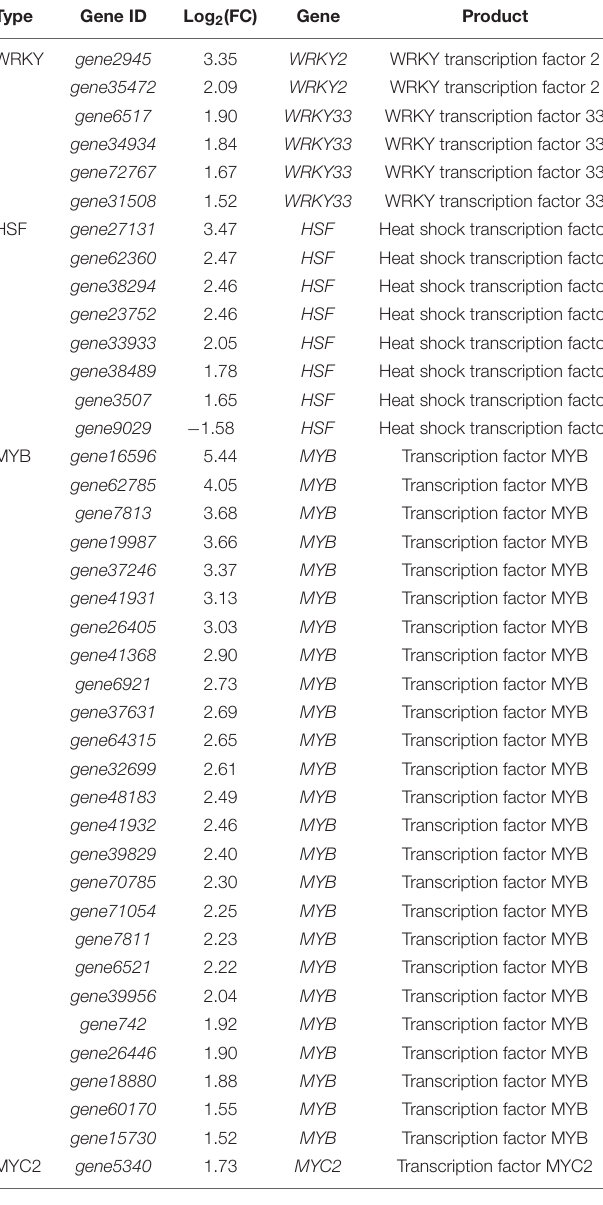
TABLE 1 | Effects of strain YC0136 on the genes related to auxin and gibberellin in tobacco. Plant hormone